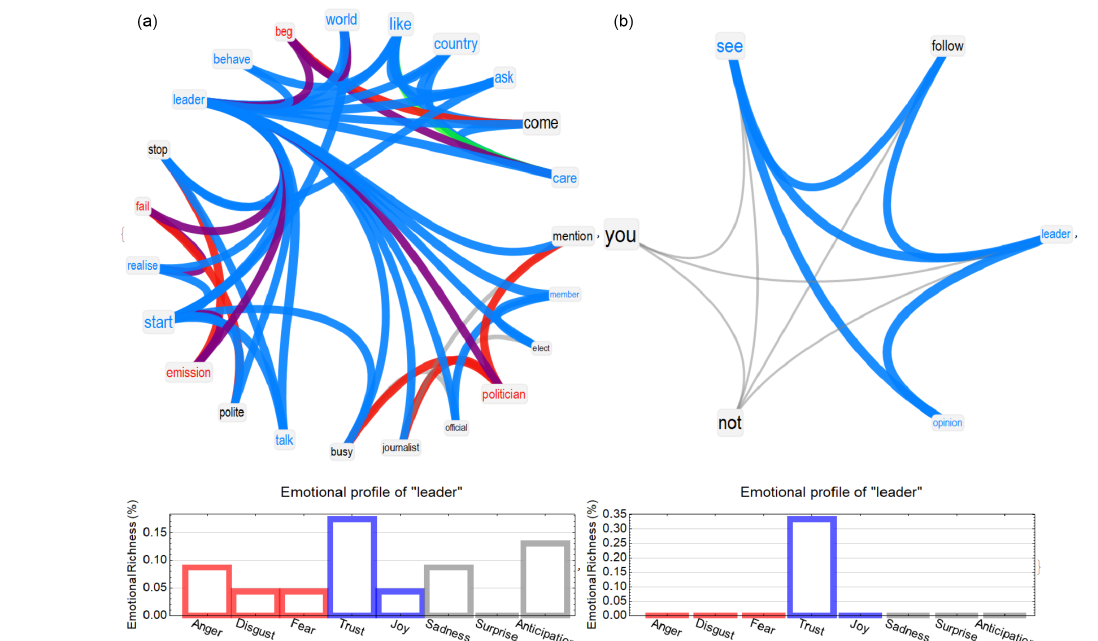
Figure A9. Speakers’ mindset reconstruction around “leader” in the speeches of Greta Thunberg (a) and Christopher Monckton (b) . We refer the reader to Fig. 1 for a detailed explanation of the colour code and to Lexicon 1 for an interpretation of the figure.